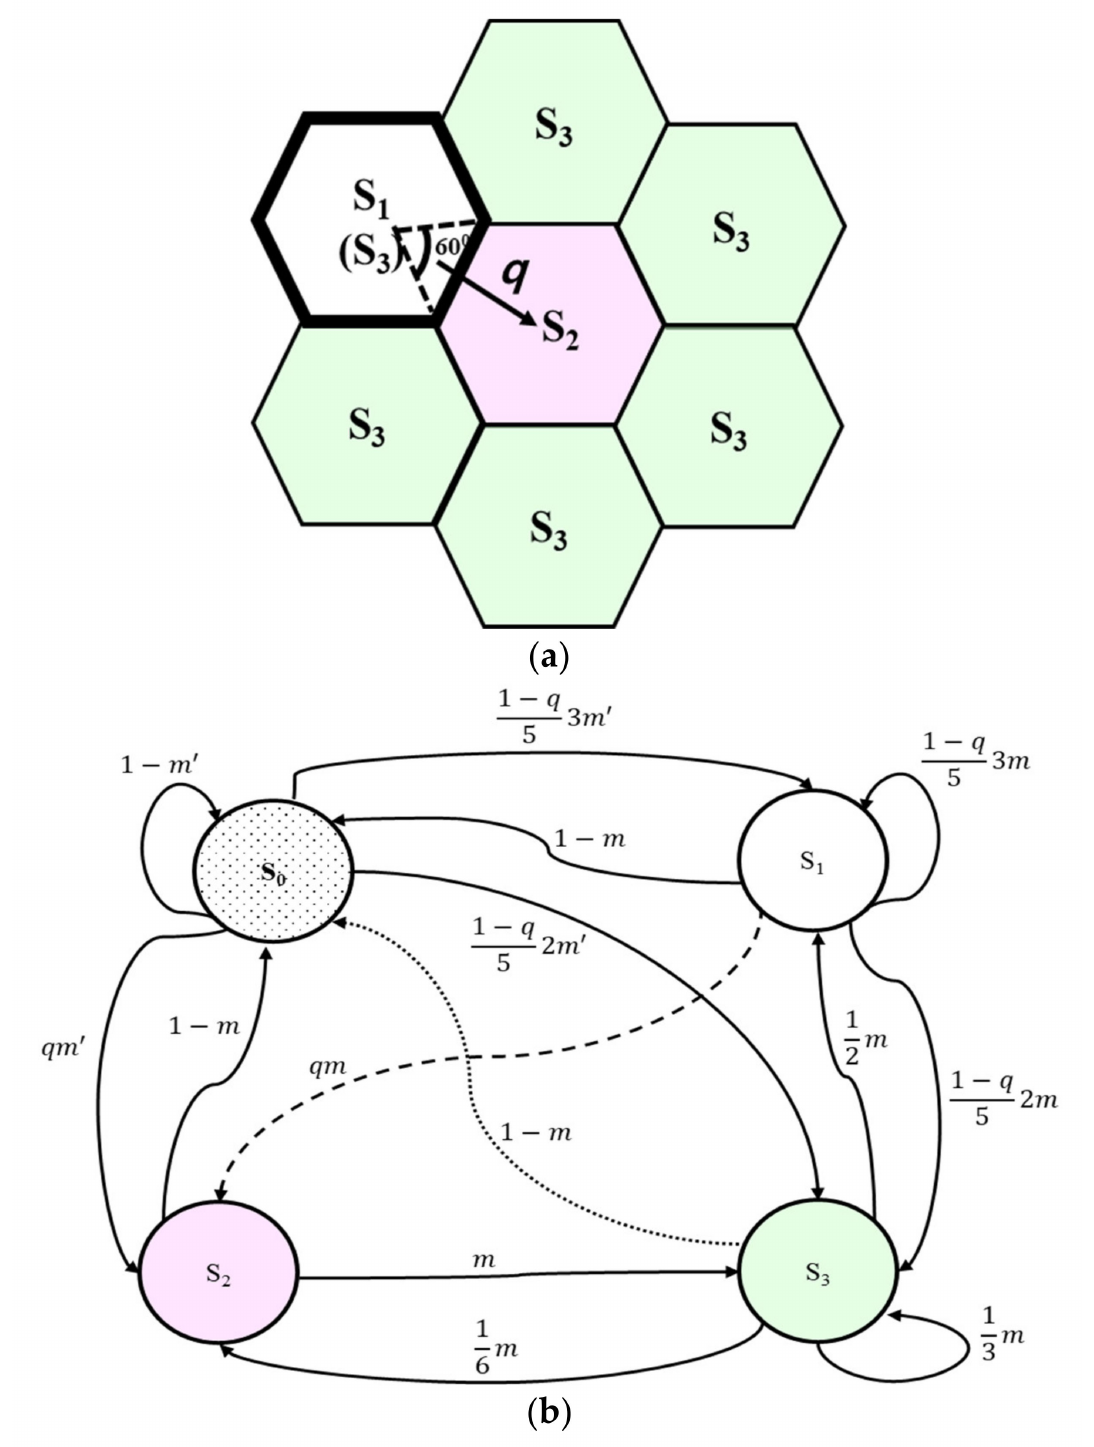
Figure 2. State transition diagram for an urban environment (small sector, 60 ◦ ). ( a ) State of a small sector (60 ◦ ). ( b ) State transition diagram of a small